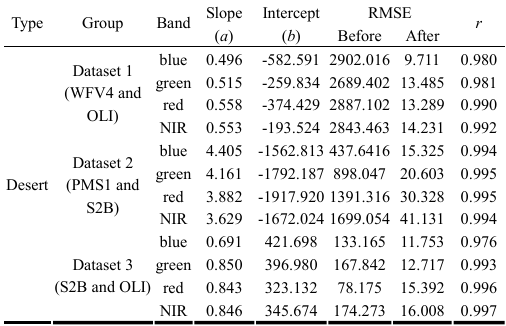
Table 5. Quantitative validation of desert study area